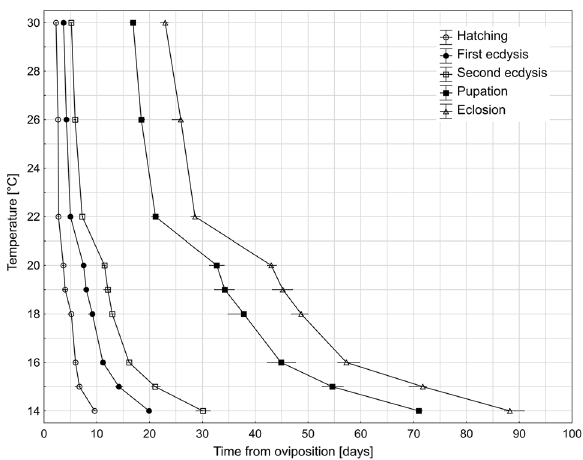
Figure 4. Isomorphen diagram for N. littoralis based on median times to reach developmental events at each of the nine temperatures tested (Supplementary Table 1). Horizontal bars represent interquartile ranges. Areas between lines represent developmental stages. Different symbols represent developmental